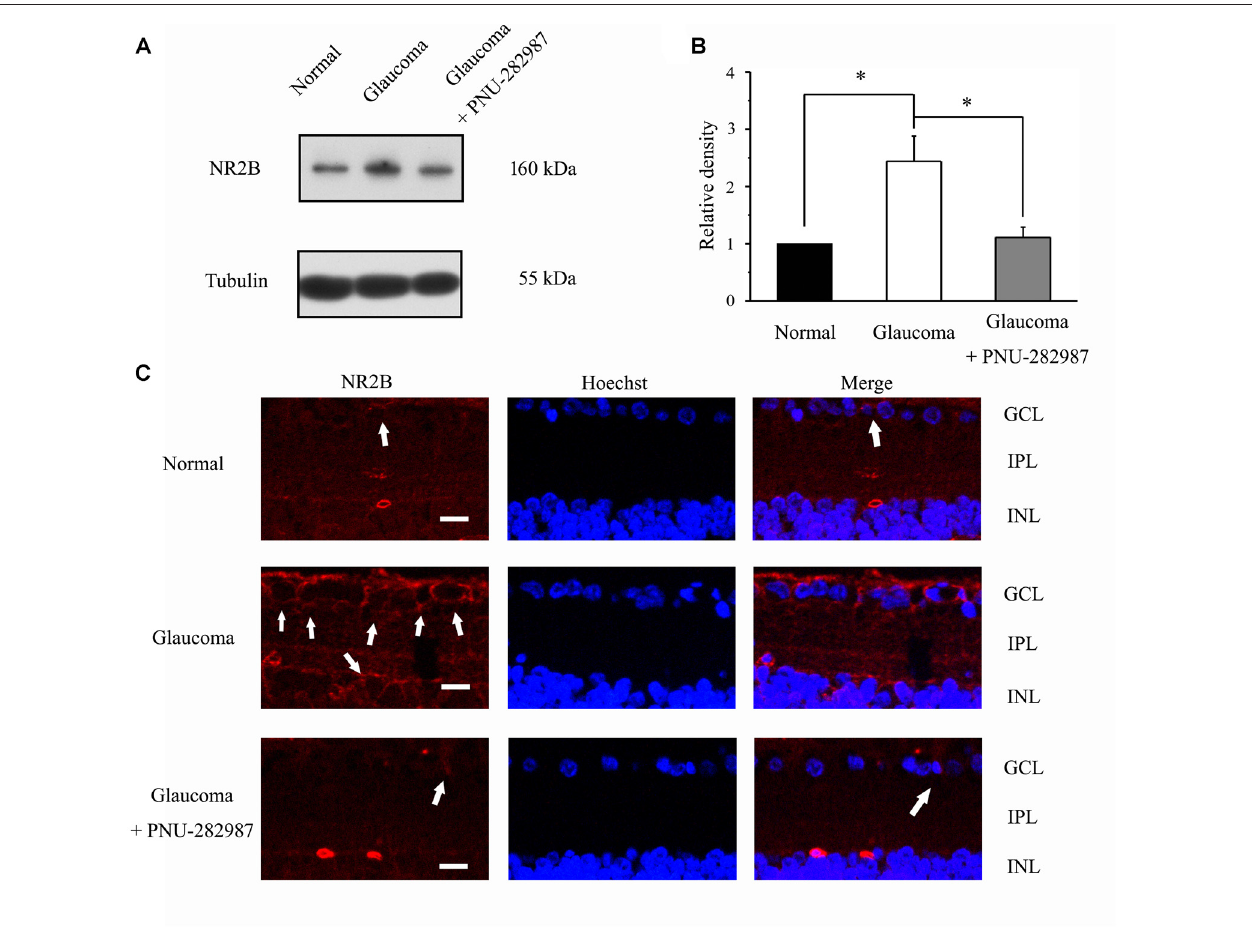
FIGURE 9 | Effect of PNU-282987 on NR2B expression levels in the retina. (A) Immunoblot analysis of NR2B in the retinas of control and glaucomatous rats before and after PNU-282987 injection. Full-length blots are presented in Supplementary Figure S1. (B) Quantitative analysis of NR2B expression. (C) Confocal images showing the distribution of NR2B labeled in the GCL (arrow) and INL (arrow) in the normal, glaucoma and glaucoma + PNU-282987 conditions. GCL, ganglion cell layer; IPL, inner plexiform layer; INL, inner nuclear layer. Scale bar: 30 µ m. The data are presented as the mean ± standard error of five samples for each experiment. ∗ p < 0.05 (one-way analysis of